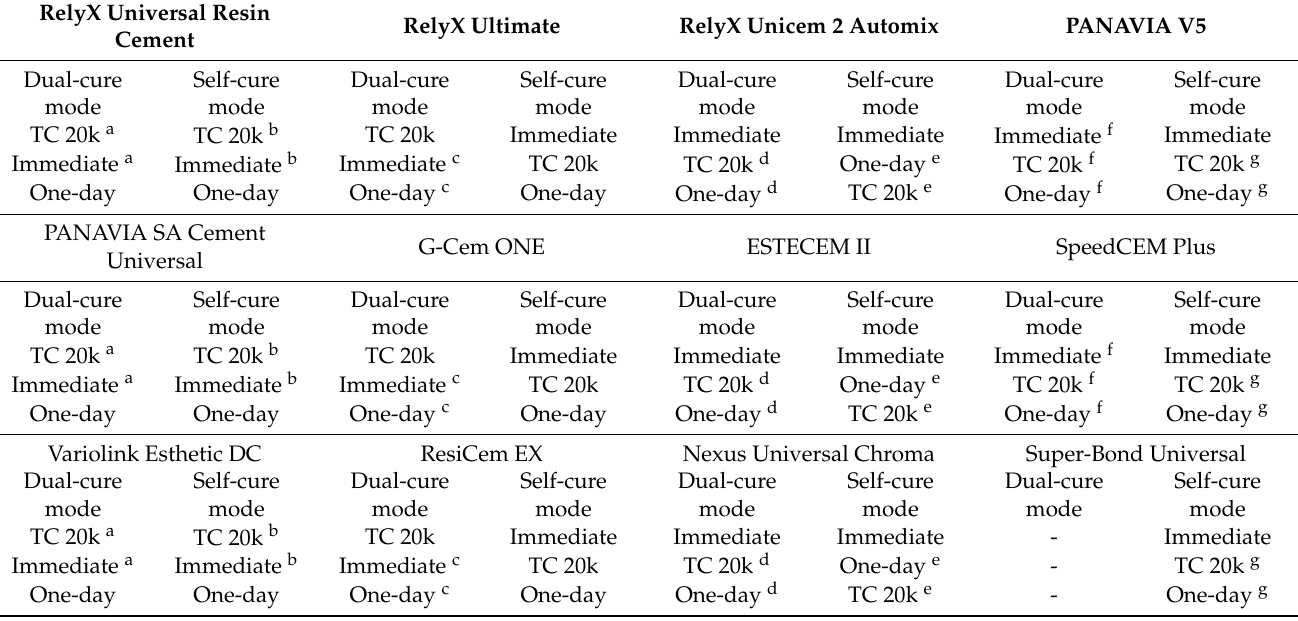
Table 8. Comparison of the means (Tukey HSD procedure) for flexural strength of each resin cement material with regard to time [superscript letters (a–g) represent groups with no significant difference, p >